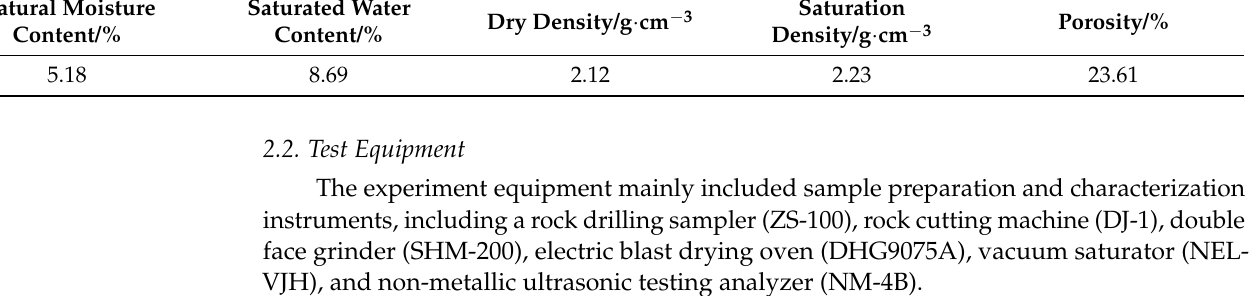
Figure 2. XRD of sandstone. Table 1. Basic physical parameters of sandstone.